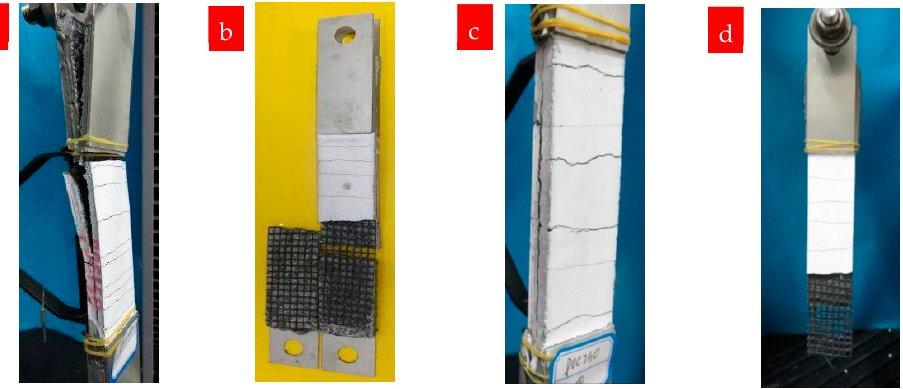
Figure 7. Stress–strain curves of the test specimens: P0C0S0, P0C1S0, and P0C2S0.